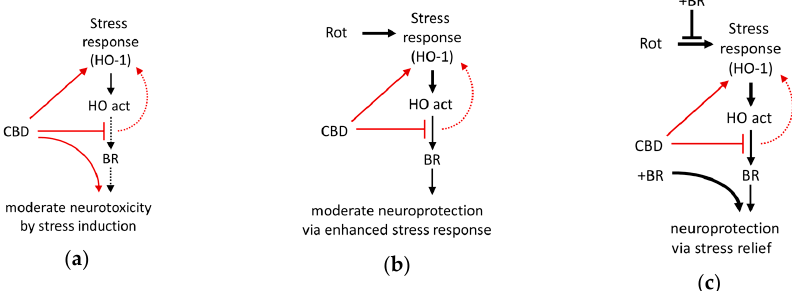
Figure 9. Schematic presentation of the suggested mechanism underlying neuroprotection mediated by the interaction of bilirubin with cannabidiol against cell stress investigated in mesencephalic cultures. ( a ) The phytocannabinoid cannabidiol (CBD) itself exerts cell stress (and moderate death of neurons), probably due to the inhibition of the heme oxygenase (HO). ( b ) In combination with enhanced oxidative cell stress caused by rotenone (Rot), CBD acts as a booster for the stress response and super-induces HO-1, resulting in an increased cellular capacity to convert heme (HO activity), which is associated with a slight increase of surviving neurons. However, the levels of bilirubin (BR) produced appear to be insu ffi cient (CBD inhibits HO activity), and only ( c ) exogenous supplementation with BR fully restores neuronal survival. Additionally, BR supplementation abolishes Rot-induced expression of the stress marker (HO-1 mRNA), which can be taken as a sign of reduced cell stress. Red lines and arrows indicate direct e ff ects exerted by CBD; black lines indicate e ff ects or pathways. Dotted lines indicate presumed (red) / insu ffi cient e ff ects